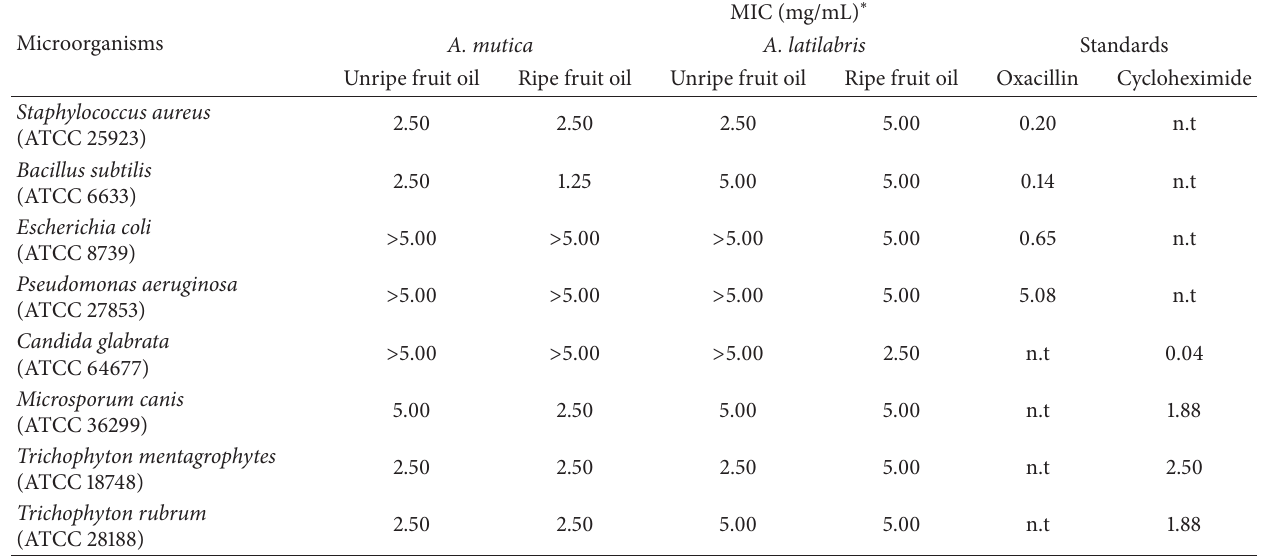
Table 2: Antimicrobial activity (MIC) of the unripe and ripe fruit oils of A. mutica and A. latilabris.